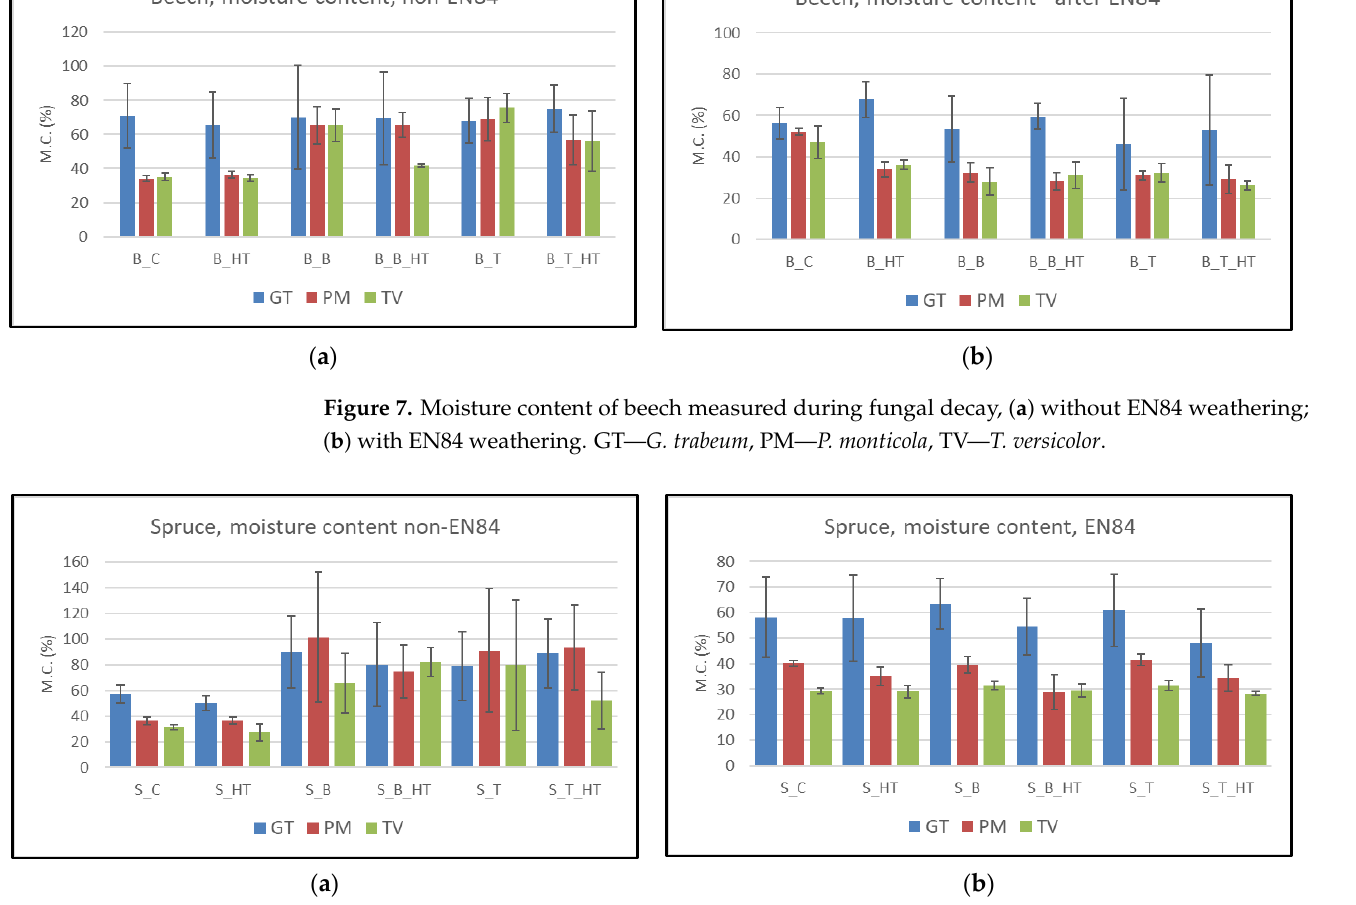
Figure 8. Moisture content of spruce measured during fungal decay, ( a ) without EN84 weathering; ( b ) with EN84 weathering. GT— G. trabeum , PM— P. monticola, TV— T. versicolor .